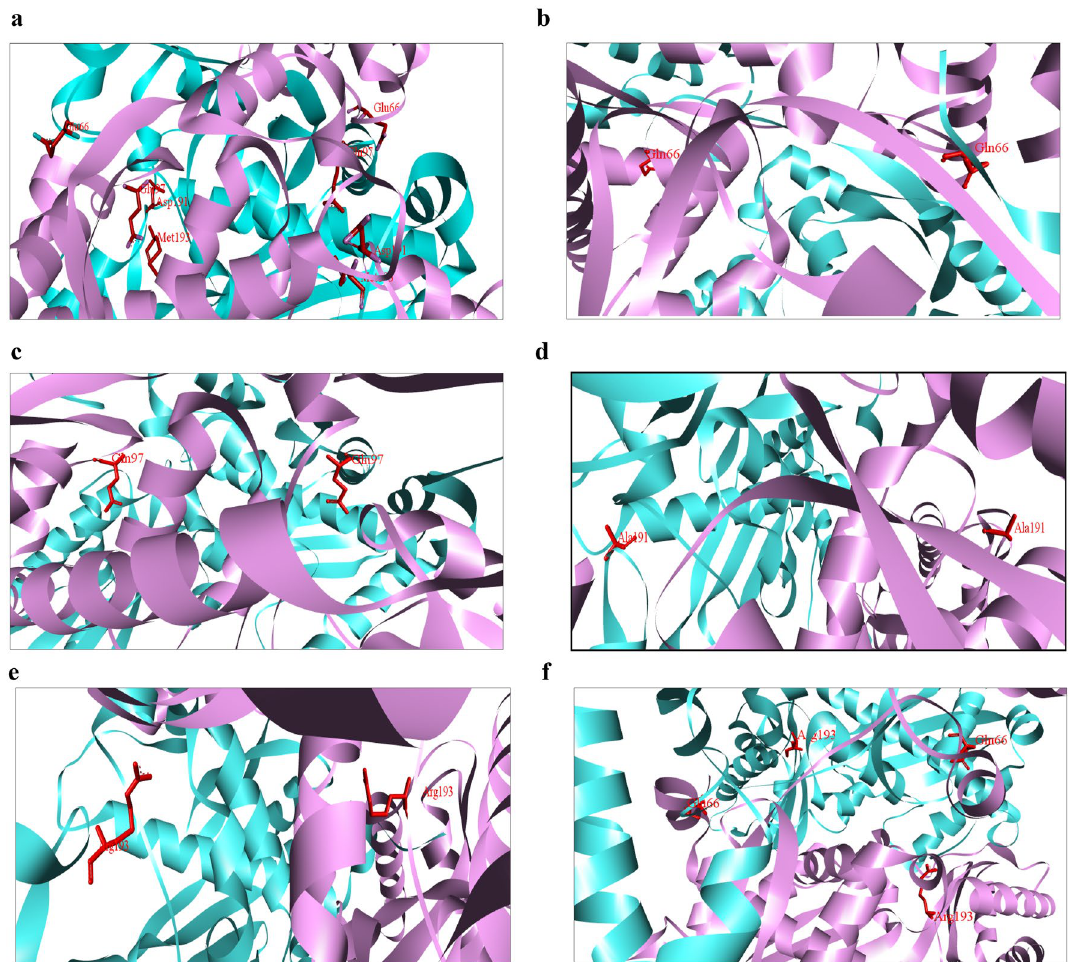
Figure 3. Structural modeling of the conformational differences between wild-type and mutant HMGR proteins of Candida glabrata ( Cg HMGR), in flat ribbon representation. ( a ) Wild-type Cg HMGR, ( b ) mutant Cg HMGRE680Q, ( c ) mutant Cg HMGRE711Q, ( d ) mutant Cg HMGRD805A, ( e ) mutant Cg HMGRM807R, and ( f ) mutant Cg HMGRE680Q-M807R. The α monomer is illustrated in pink, the β monomer in cyan, and the mutation in stick representation (red). Made using Discovery Studio